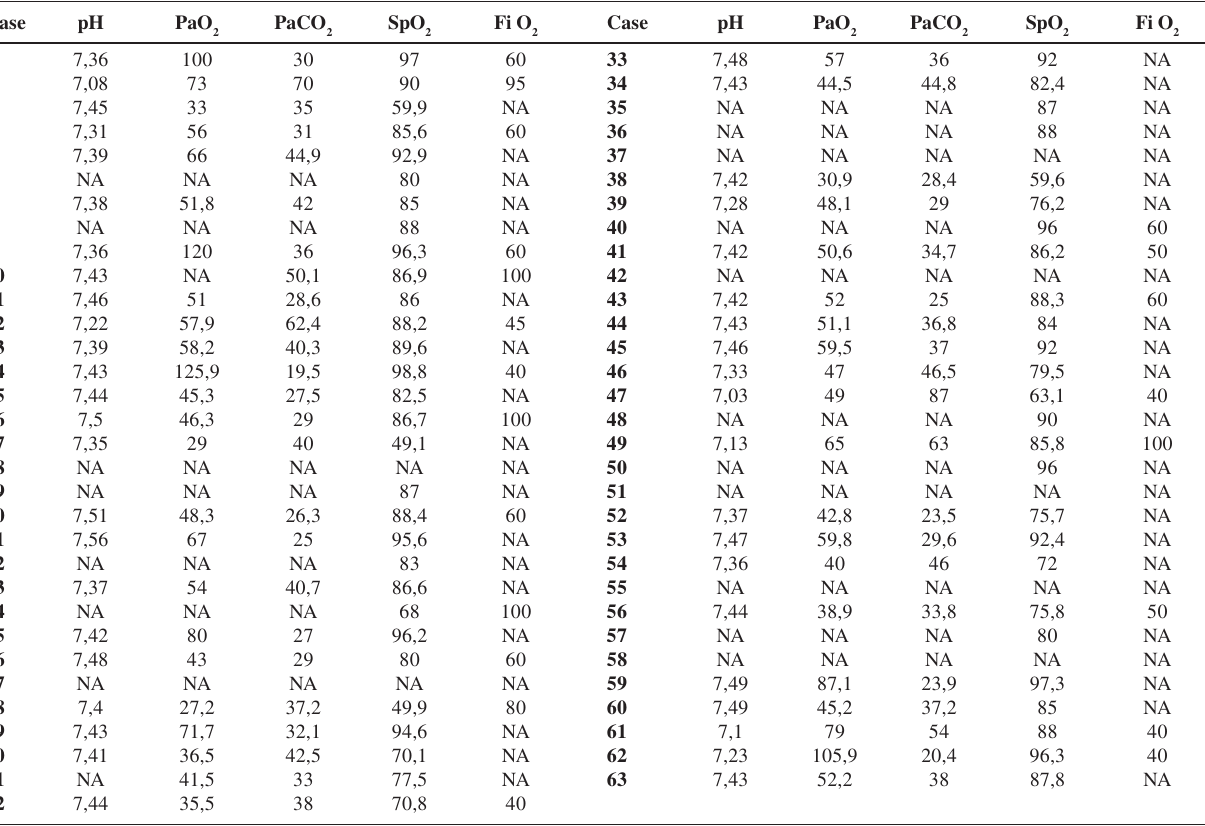
Table 1 - Gasometric data of the 63 patients studied, previous to surgical lung